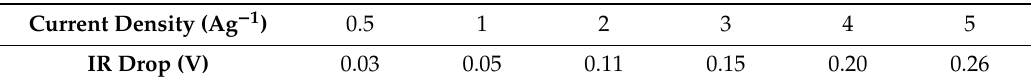
Figure 10. ( a ) CV curves at various scan rates for CuS / C-120@PANI electrode; ( b ) GCD curves at various current densities for CuS / C-120@PANI electrode; ( c ) Specific capacitance values of di ff erent various scan rates and current densities; ( d ) EIS curve of CuS / C-120@PANI with equivalent circuit inset; ( e ) Cycling performance of the CuS / C-120@PANI electrode at 10 mV − 1 for 3000 cycles; ( f ) Specific capacitance of CuS / C-80, CuS / C-120, CuS / C-160 and CuS / C-120@PANI at di ff erent current densities. The value of IR drops at di ff erent current densities for CuS / C-120@PANI electrode. PANI: